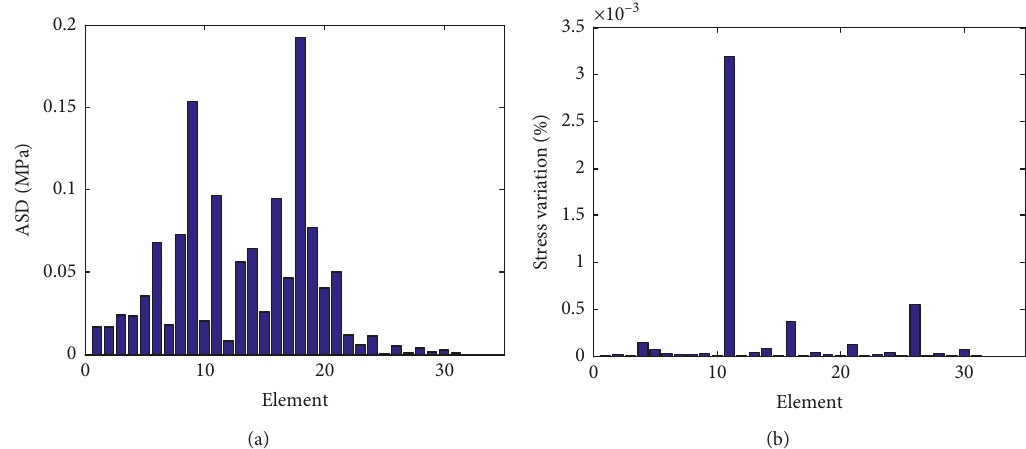
Figure 13: Multiple damages at elements 9 and 18 using 2% noise-contaminated displacements of (a) ASD and (b) stress variation rate.